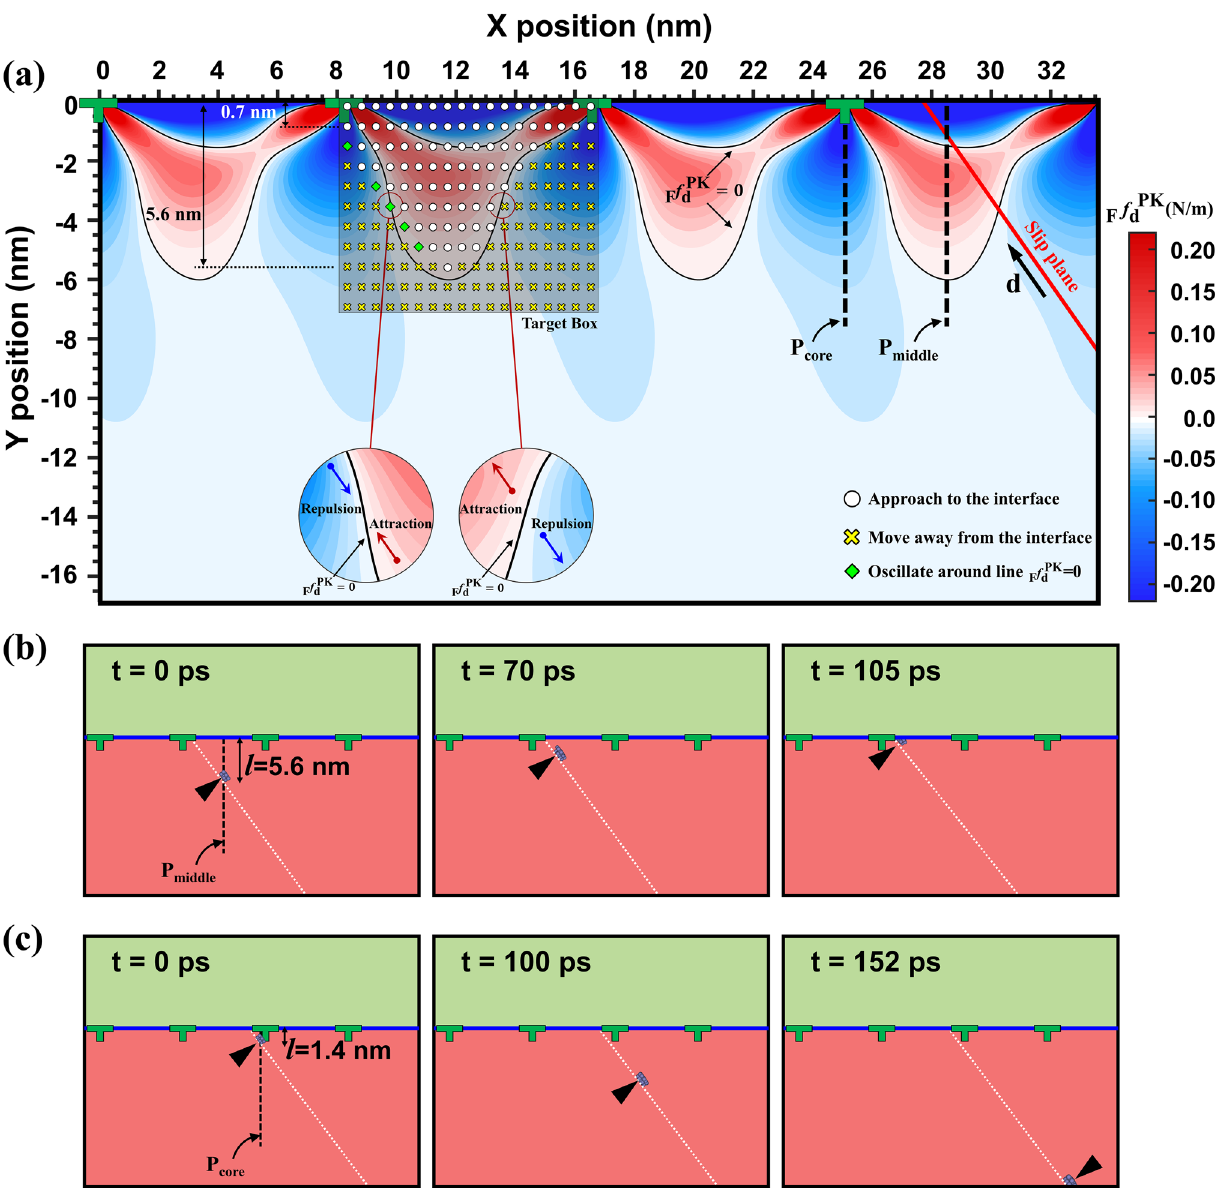
Figure 3. ( a ) Contour plot of resolved P–K force within the ferrite layer. The target box represents MD simulation results of lattice dislocation trapping ability with respect to the initial position of lattice dislocation. PK = 0 borderline and the slip plane, respectively. White circle, yellow Solid black and red lines represent F f d x-mark, and green square in the target box indicate that the lattice dislocation is attracting by the interface, moving away from the interface and oscillating around the borderline, respectively. The insets reveal the direction of P–K force near the borderline at the left and right sides of the target box, providing metastable and unstable trapping sites, respectively. ( b ) Trajectory of lattice dislocation trapping mechanism for dislocation located at P middle region with l = 5.6 nm. ( c ) Trajectory of lattice dislocation repulsion mechanism for dislocation located at P core region with l = 1.4 nm. Solid blue and dashed white lines in ( b ) and ( c ) represent the ferrite/ cementite interface and the slip plane in the ferrite layer, respectively. The black triangles in ( b ) and ( c ) indicate the position of lattice